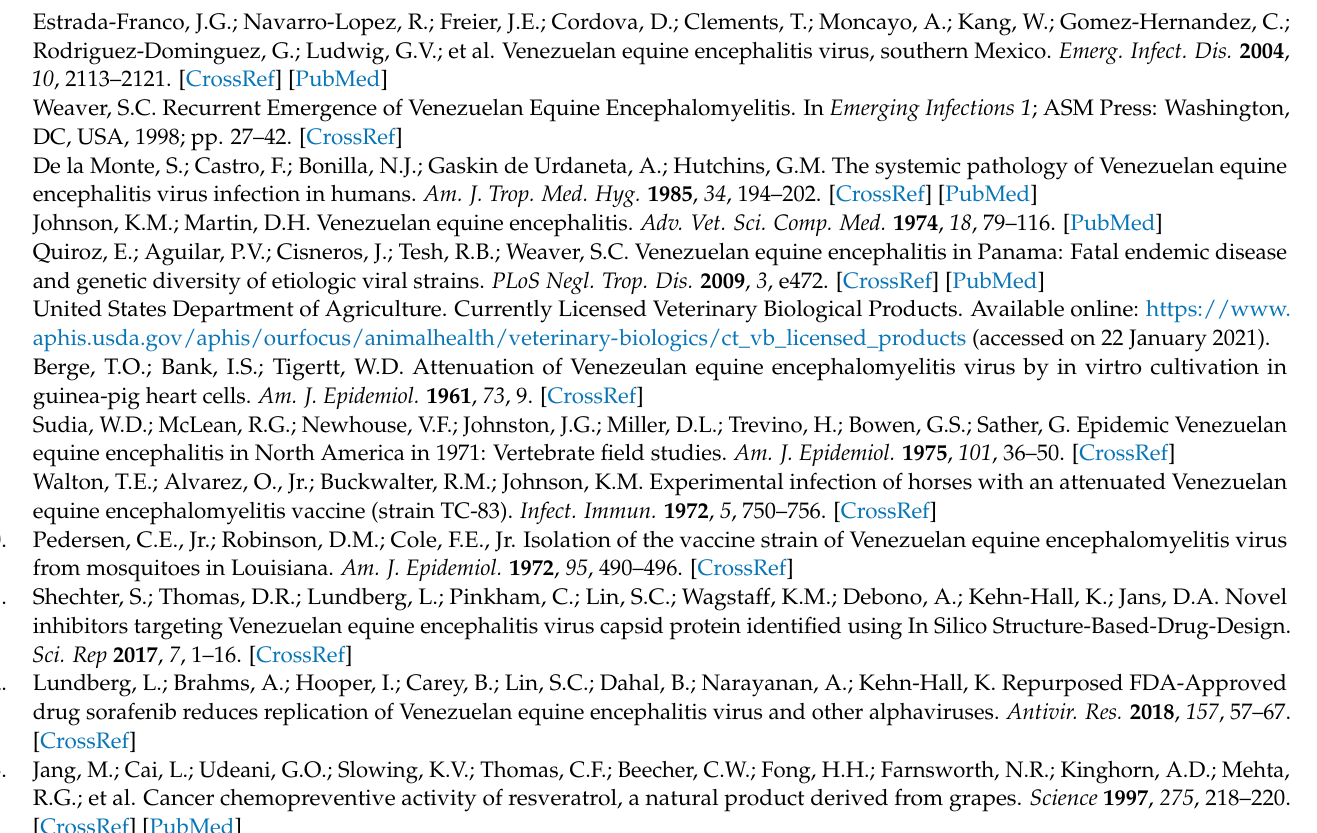
phase.; Figure S2: Apoptosis of VEEV-infected cells with resveratrol treatments.; Figure S3: Docking of resveratrol (yellow) in the cryo-EM structure of VEEV E1-E2 glycoprotein.; Figure S4: Direct interaction between resveratrol and VEEV virions.; Figure S5: Resveratrol reduced lethal VEEV infection in